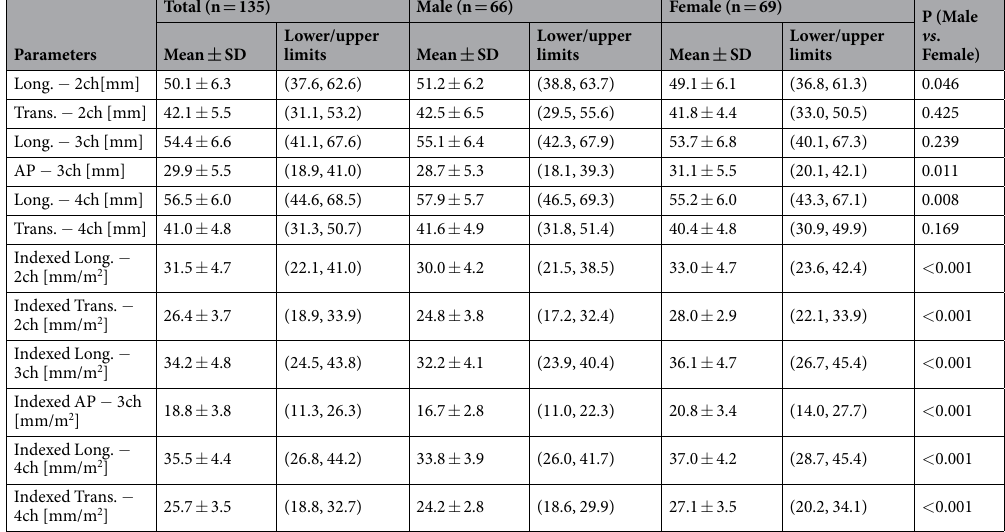
Table 2. Total and gender specific left atrial dimensions (mean ± SD, and reference range) (n = 135). Lower/ upper limits calculated as mean ± 2 SD; Long., Longitudinal dimension; Trans, Transverse dimension; AP, Antero-posterior dimension; 2ch, 2-chamber view; 3ch, 3-chamber view; 4ch, 4-chamber view; Indexed dimensions are calculated by corresponding dimensions in mm divided by BSA in m 2 .